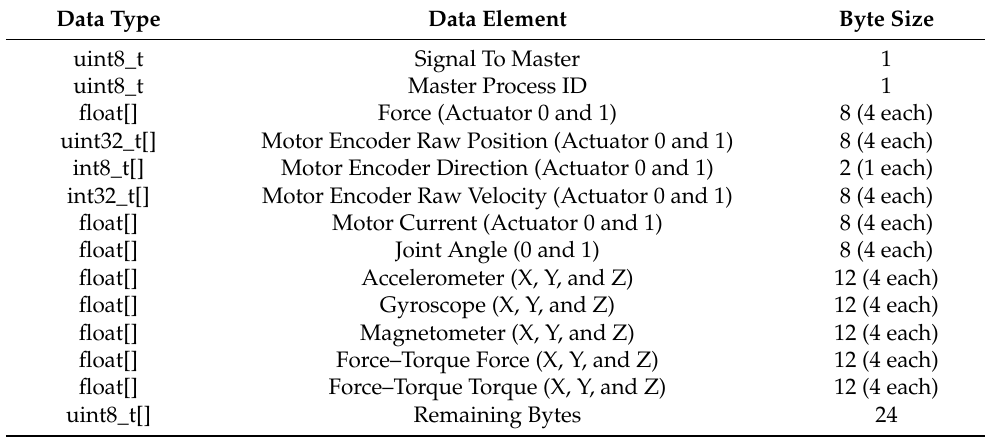
Table 1. CONTROL signal data TIVA-to-master.